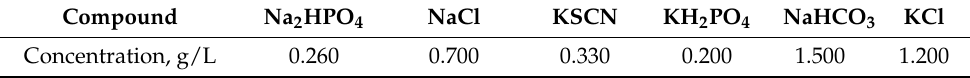
Table 4. SBF—Artificial saliva chemical